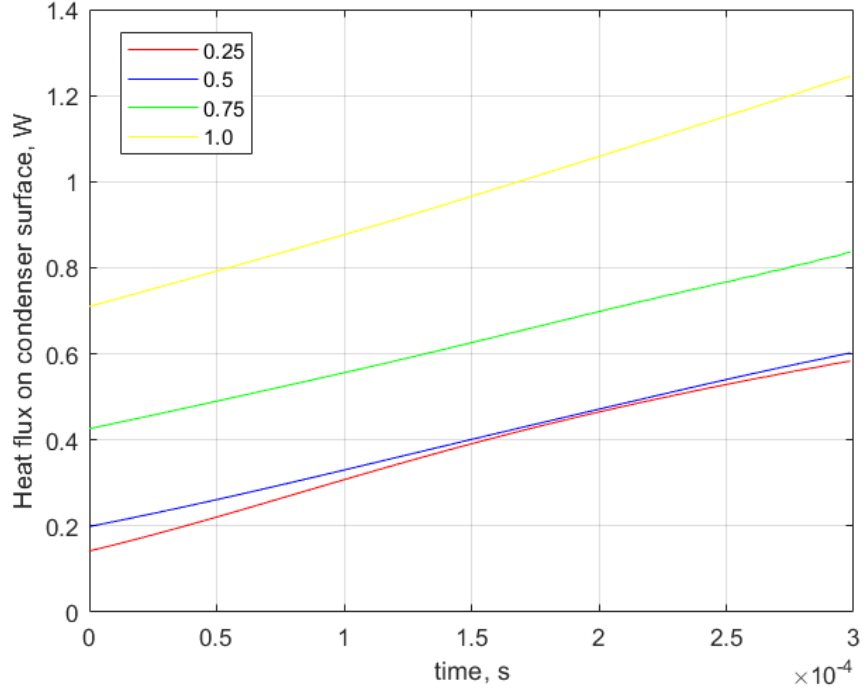
Figure 2. The results of mesh independence study for heat flux on the condenser surface. In the simulation, for the calculation of the time differential, the Euler scheme was used, a Gauss van Leer was used for divergence calculations, expecting the divergence in turbulence equations, where a Gauss linear was employed. For laplacians and gradients, a Gauss linear scheme was used.